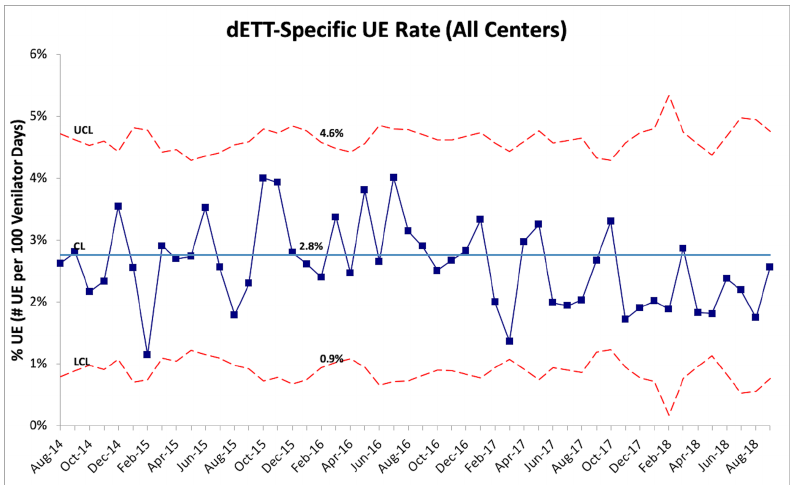
Figure 4. U-charts displaying the monthly UE rate for individual centers. Special cause variation (rule of shift) was noted at centers B and D only. CL = center line (mean), UCL = upper control limit, and LCL = lower control limit. Further analysis of UEs based on classification as dETT versus rETT showed that the majority of UEs at all the RPCs were classified as dETT (N = 941, 81%) versus rETT (N = 226, 19%). Following the implementation of one or more PDSA cycles, no appreciable change in the combined rate of dETTs was noted (Figure 5). No special cause variation was observed for the rate of dETTs; however, the rate fell below the baseline for ten of the last eleven months of the project. On the other hand, a substantial reduction in the com- bined rate of rETTs was noted with a special cause variation observed beginning in Octo- ber 2016 when the combined rETT UE rate decreased from 0.9 to 0.3 per 100 ventilator days (67% reduction) (Figure 6).